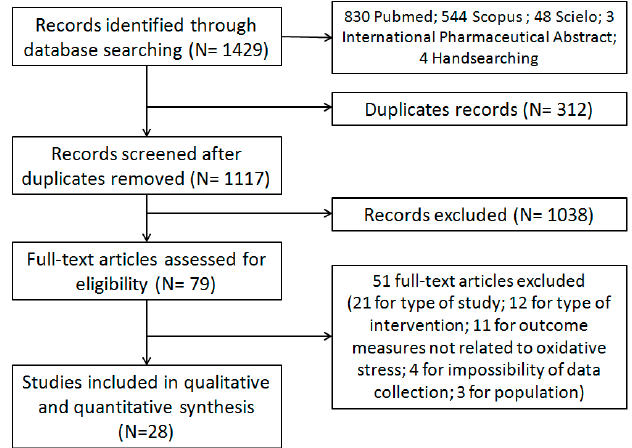
Figure 1. Flowchart of included Randomized Controlled Trials.